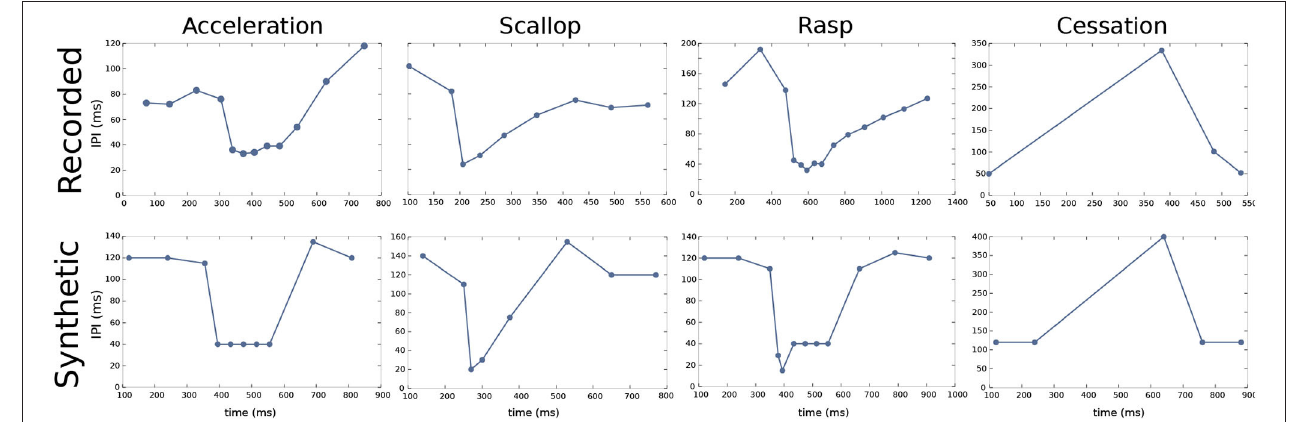
FIGURE 2 | Characteristic SPI patterns recorded from freely-behaving Gnathonemus petersii specimens (top) and examples of corresponding synthetic SPIs to evolve and validate the electromotor command network model (bottom). Regarding the different SPIs, accelerations are sustained IPI shortenings to a series of almost regular shorter IPIs; scallops are sudden drops to very short IPIs (below the minimum IPI in accelerations) followed by a recovery to regular resting IPIs; rasps are a combination of a sudden drop to very short IPIs as in a scallop followed by a step increase of IPIs duration for a sustained series of IPIs; cessations are activity dropping in the EOD generation for periods up to 1 s. All of them have different temporal structures (Moller, 1970; Moller et al., 1989; Carlson and Hopkins, 2004b), different behavioral significance, and they result from different activations within the electromotor network ( Carlson, 2003; Carlson and Hopkins, 2004a). Recorded SPIs were obtained from experimental data recordings of living G. petersii specimens and were used as targets for the R-GA configuration of the model. A set of synthetic SPIs were constructed preserving the characteristic temporal structure of previously reported SPI patterns (Carlson and Hopkins, 2004b), they were used as targets for obtaining the S-GA configuration of the